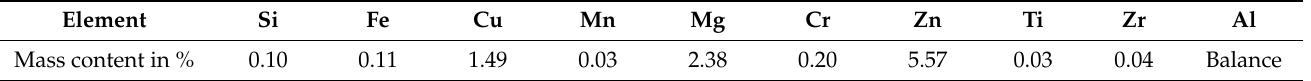
Table 1. Chemical composition of the investigated precipitation-hardenable aluminum alloy AA7075.